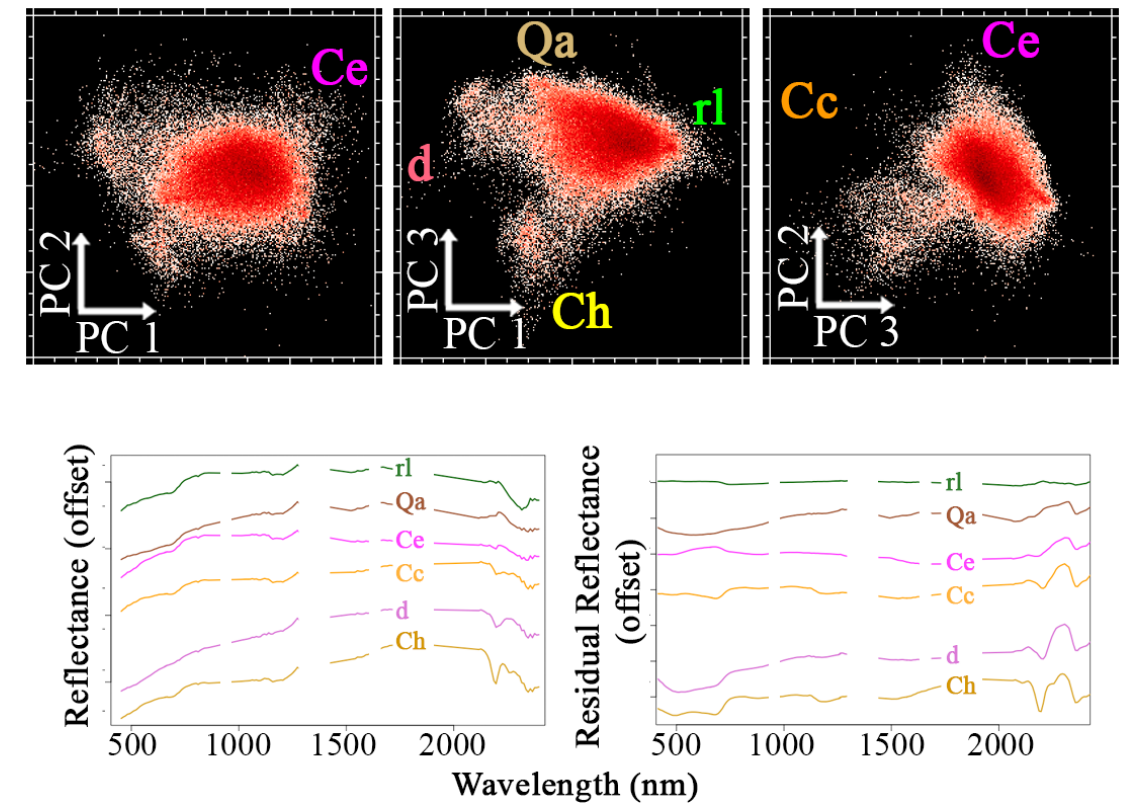
Figure 6. Mixture residual feature space ( top ) and example endmember residual spectra ( bottom ). Viewed as surface reflectance (lower left), all endmember spectra show similar overall convex shapes, with similar VNIR brightness, diverging SWIR brightness, and low-amplitude SWIR absorptions. Viewed as mixture residual spectra (lower right), significant differences in VNIR curvature and SWIR absorption features dominate. Surface reflectance spectra are highly correlated (median Spearman +0.84; MAD 0.20; range +0.38 to +0.97), while mixture residual spectra are uncorrelated (median Spearman +0.04; MAD 0.63; − 0.52 to +0.84). Endmembers were found and labeled by interactive exploration of geographic pixel locations, with comparison against the geologic map and targeted field observations. Geologic units are described in more detail in Section 4.5, below. Rl: lower member of Reed Dolomite; Qa: Quaternary alluvium; Ce: Emigrant Formation; Cc: Campito Formation; d: Deep Springs Formation; Ch: Harkless Formation.